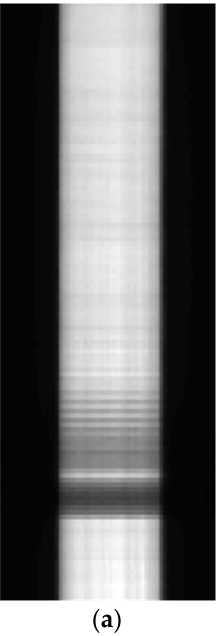
Figure 16. Weather at the time of the observation of December 3rd at 15:00.